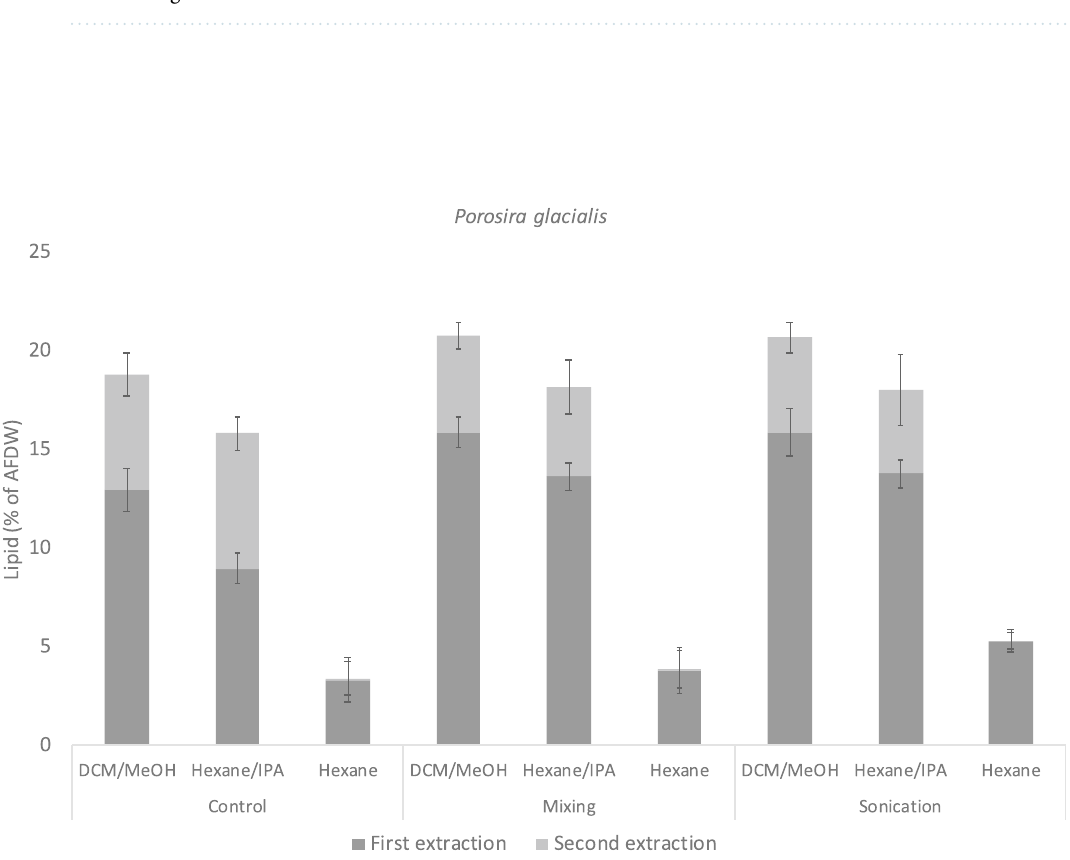
Figure 1. The effect of cell disruption on thawed biomass of Porosira glacialis . ( a ) Control, ( b ) manual grinding using a PTFE pestle, ( c ) microwave, ( d ) lyophilization, ( e ) sonication, ( f ) Ultrathurax. All images were captured at 100 × magnification.